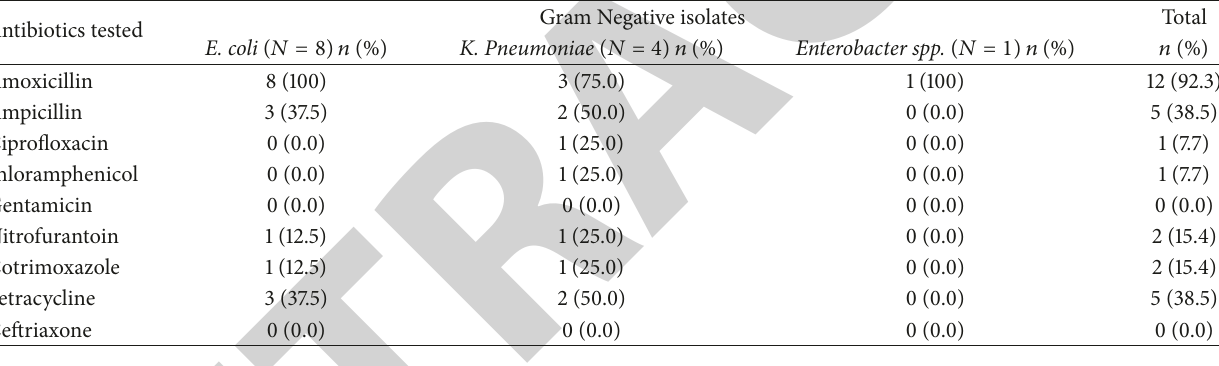
Table 7: Antimicrobial resistance pattern of gram-negative bacteria isolated from urine of diabetic and nondiabetic patients attending Debre Tabor Hospital, Northwest Ethiopia, 2015.